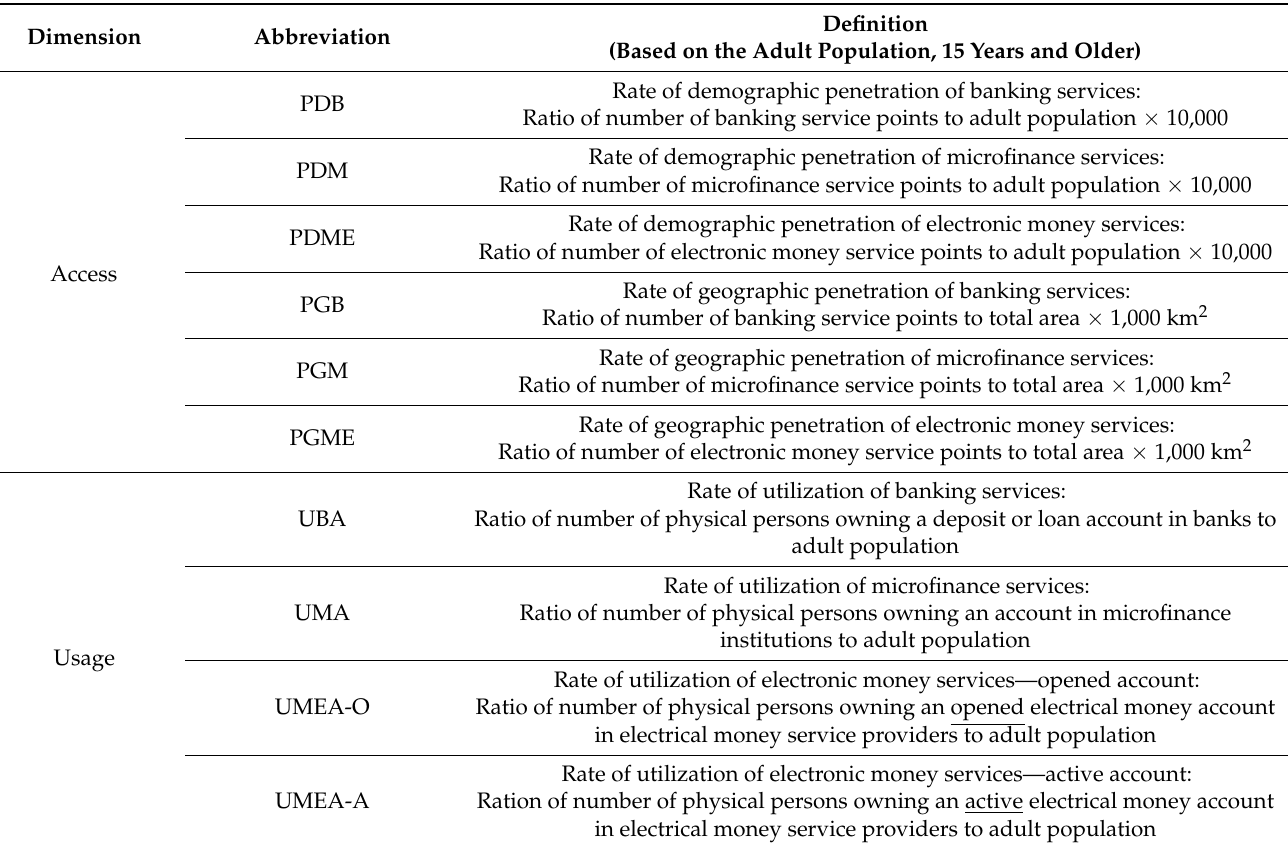
Table 2. Description of the selected financial inclusion